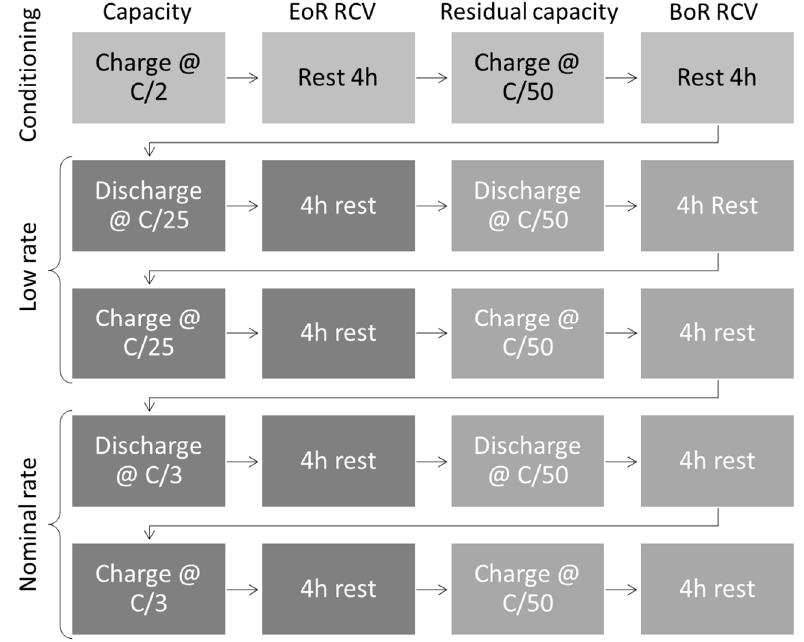
Figure 5. The reference performance test (RPT) test protocol. EoR stands for end of regime and BoR stands for beginning of regime.